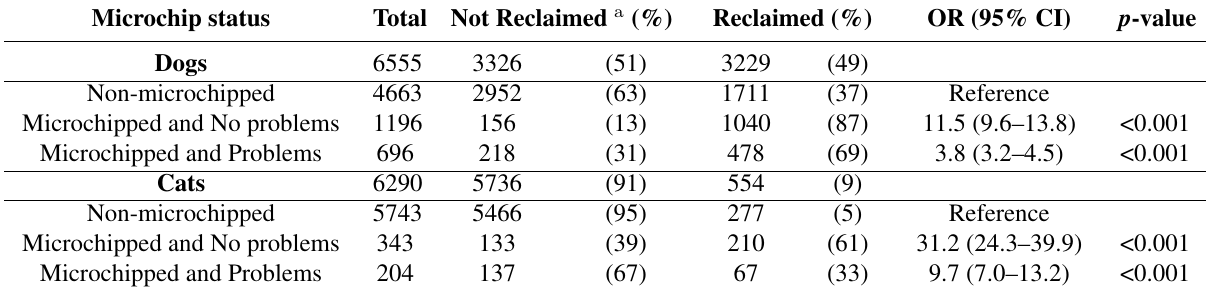
Table 5. Results of logistic regression analyses describing the relationship between microchip status and reclaim outcome of stray adult dogs and cats admitted to RSPCA-QLD shelters (January 2012–December 2013). Percentages for reclaim status within each microchip status are shown in brackets.